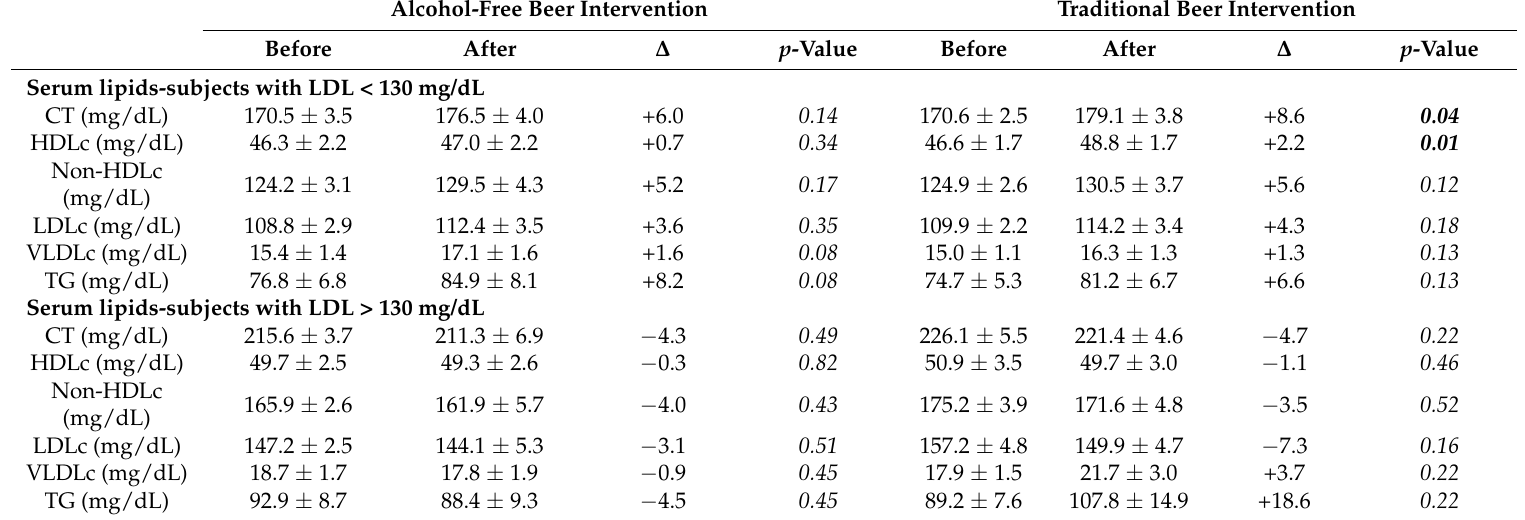
Table 5. Serum lipid levels before and after four-week dietary intervention with alcohol-free and traditional beer in subjects with LDLc at baseline below and above 130 mg/dL.